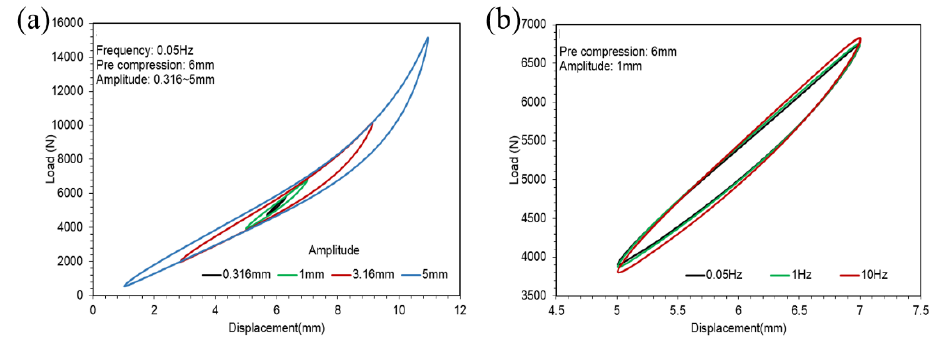
Figure 7. Hysteresis loops of the CT rubber spring. (a) Hysteresis loops of different amplitudes of the ST rubber spring in 0.05 Hz with 6 mm pre-compression. (b) Hysteresis loops of different frequencies in a 1 mm amplitude with 6 mm pre-compression.